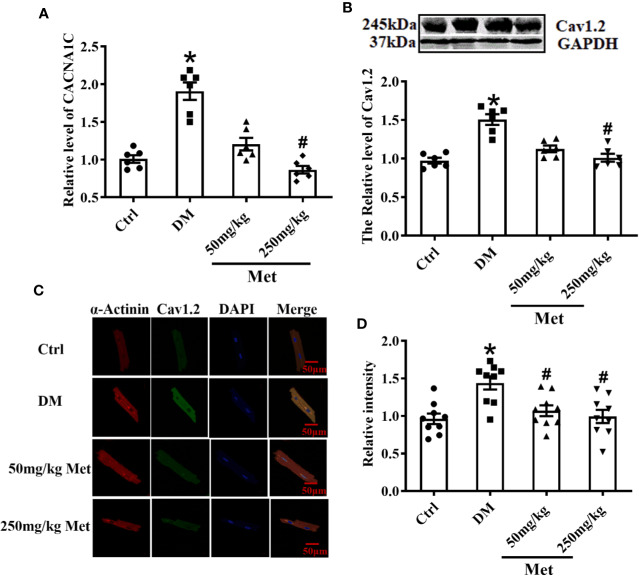
Treatment effects of metformin on the mRNA and protein levels of Cav1.2 in diabetic mice. (A) Relative levels of CACNA1C with metformin in diabetic mice detected by real-time PCR, n=6. (B) Relative levels of Cav1.2 in the Ctrl group, DM group, and the metformin-treatment group detected by western blot, n=6. (C) Representative confocal images of α-Actinin (left) or CaV1.2 (middle) in the Ctrl group, DM group, and the metformin-treatment group. (D) Relative levels of Cav1.2 in the Ctrl group, DM group, and the metformin-treatment group by immunofluorescences, n=9. Values represent mean ± SEM, *P < 0.05 versus Ctrl, #P < 0.05 versus DM.